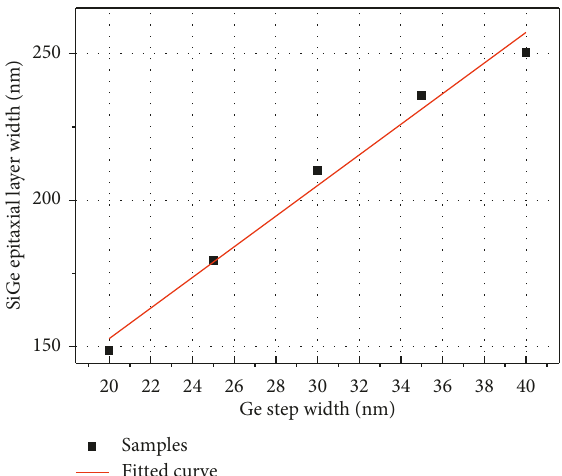
Figure 10: Variation of the SiGe epitaxial layer width for stable strain with the Ge step